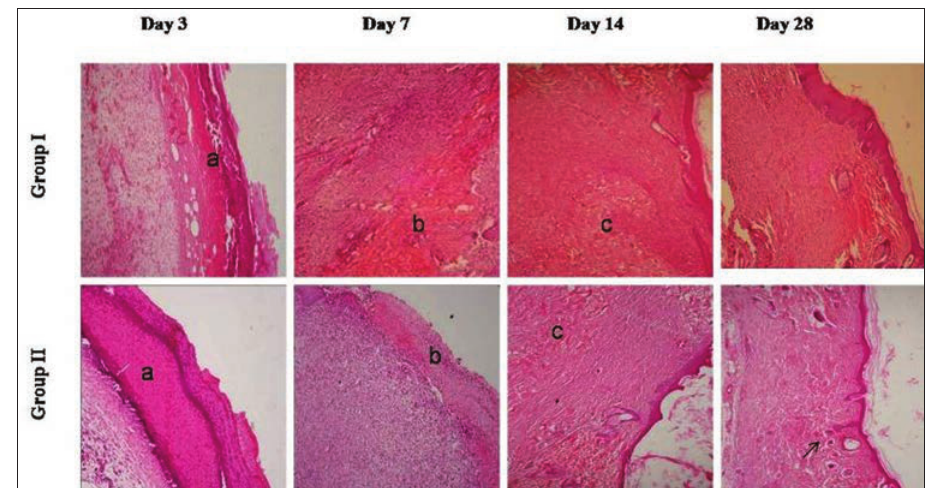
Figure-10: Histological appearance of cross section of wound area (hematoxylin and eosin stain, ×40), (a) Implanted matrix, (b) disintegration of matrix in host tissue, (c) neo collagen deposition, arrow - neovascularization. complex II and costimulatory molecule